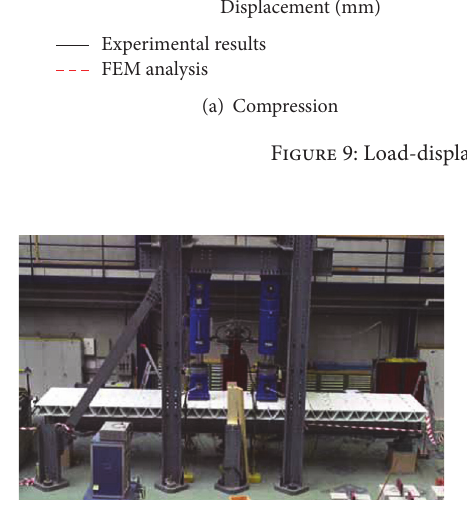
Figure 10: Four-point bending experiments on FRP-steel girder system [7].